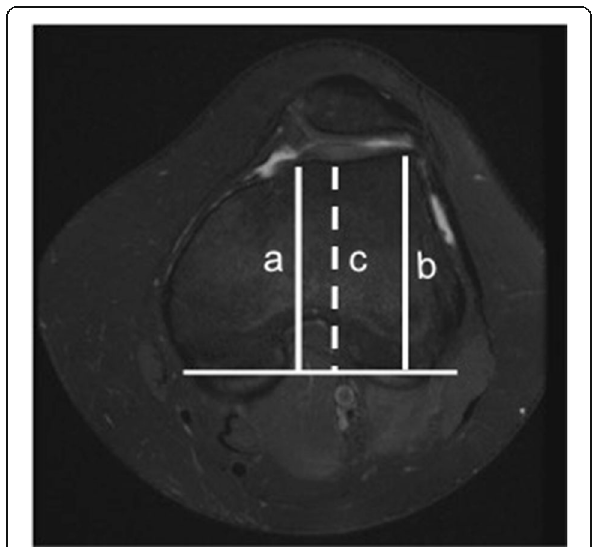
Fig. 1 Trochlear depth assessment. Axial PDFS left knee MR image, demonstrating the method used for the measurement of trochlear depth. First, a line is drawn paralleling the posterior femoral condyles surfaces. Perpendicular to this baseline, trochlear depth is calculated by measuring the mean of the maximum AP distance of the medial ( a ) and lateral ( b ) femoral condyles minus the distance between the deepest point of the trochlear groove and the line paralleling the posterior condylar surfaces ( c ). Trochlear depth=[(a +b)/2] − c